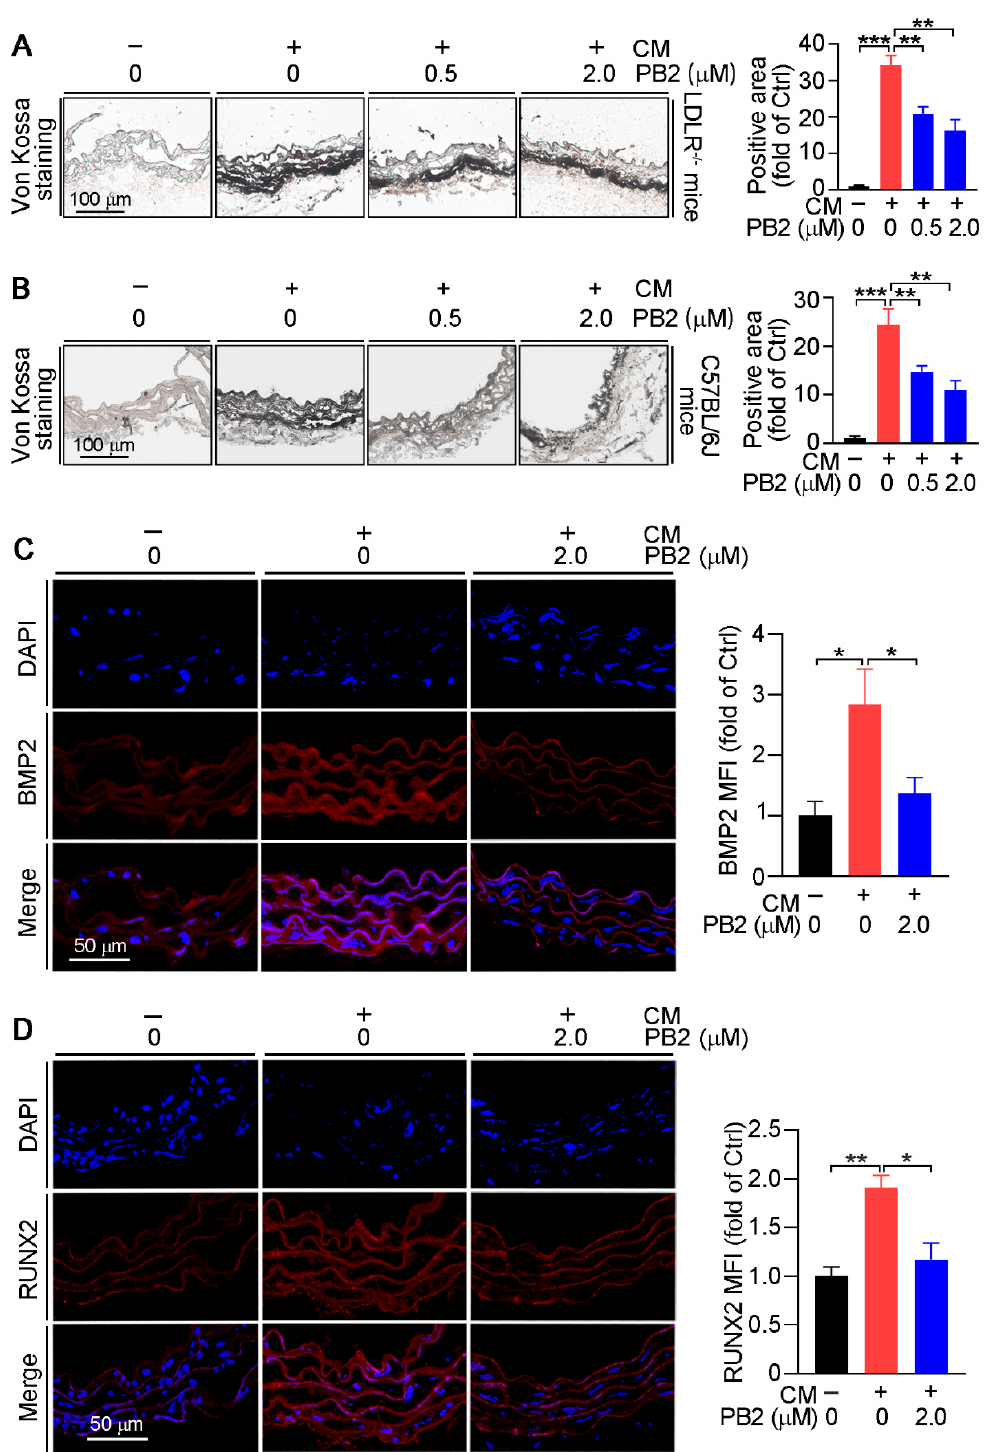
Figure 5. Procyanidin B2 inhibits calcification in the aortic ring. ( A ) Thoracic aortas of LDLR − / − and ( B ) C57BL/6J mice were collected and cut into 0.5-cm rings, followed by culture in a normal medium (Ctrl), CM, or CM plus PB2 at the indicated concentrations for 2 weeks. Calcium deposition in aortic rings was determined by von Kossa staining, and the images were photographed. ** p < 0.01, *** p < 0.001 (3 mice per group were used, and at least three samples from each mouse were taken as technical replicates). ( C ) BMP2 and ( D ) RUNX2 expression were determined by immunofluorescent staining with the quantification of MFI in the thoracic aortic rings of C57BL/6J mice after cultured in a normal medium (Ctrl), CM, or CM plus PB2 for 2 weeks. * p < 0.05, ** p < 0.01 (3 mice per group were used, and at least three samples from each mouse were taken as technical